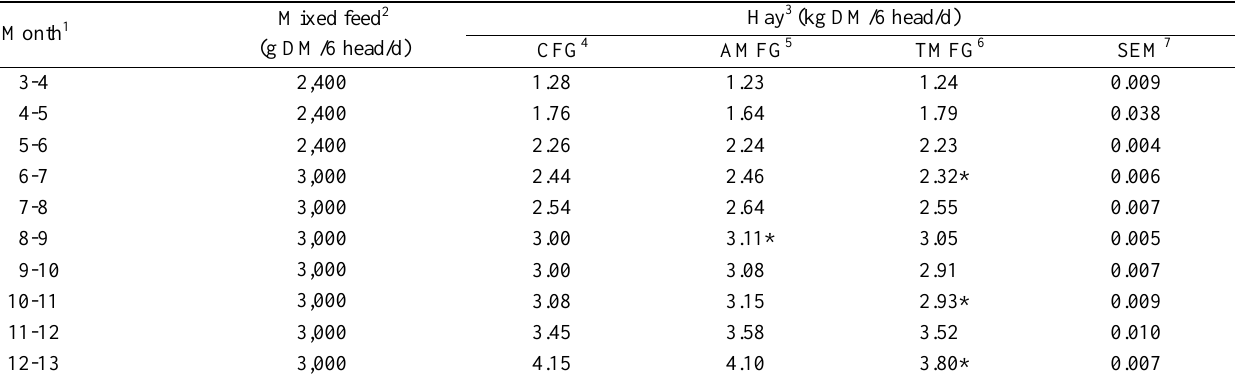
Table 5. Effect of feeding Awamori-pressed lees mixed feed (AMF) and Tofu lees mixed feed (TMF) on hay intake Month